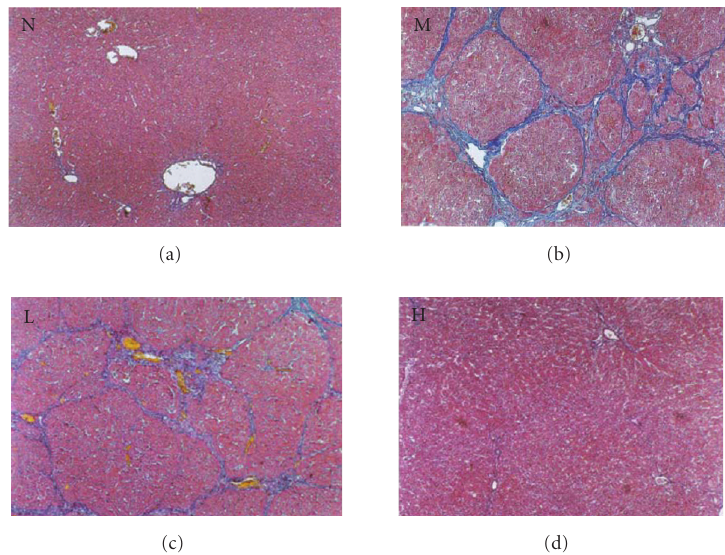
Figure 3: Liver histopathology of the rat detected by Masson trichrome staining. N represented the normal control group; M represented the model group; L represented the group treated with low dose of thalidomide; H represented the group treated with high dose of thalidomide. Fibrotic bands of liver shown in M, L, and H (original magnification N, M, L, H, × 100).